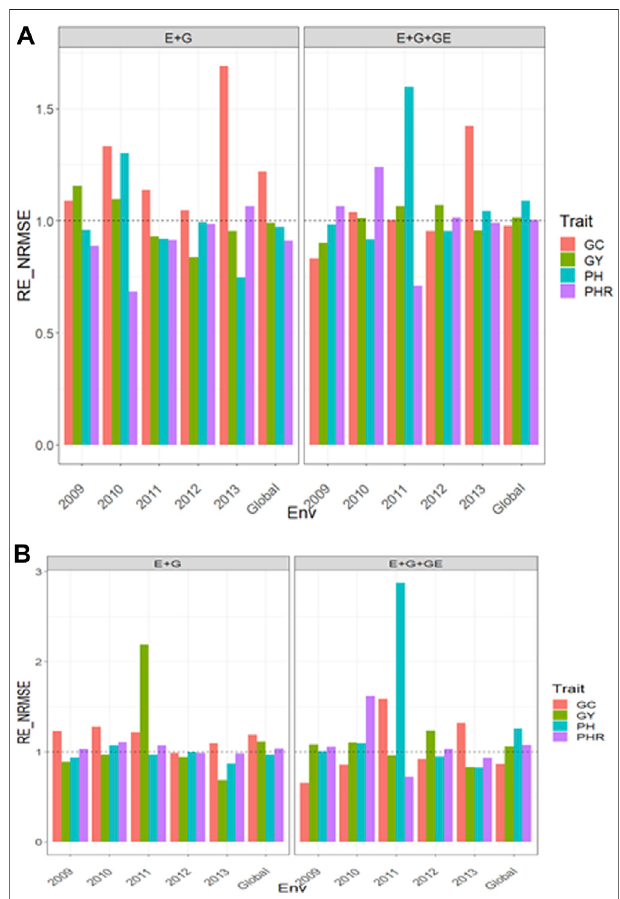
FIGURE 9 | Relative ef fi ciency in terms of normalized root mean square error (RE_NRMSE) computed by dividing the NRMSE under the best linear unbiased predictor model (GBLUP) between the NRMSE of the partial least squaresregressionmethod.Predictionperformanceisreportedforeach environment and across environments (Global) in dataset 14 (Japonica), also withtwopredictors(E+GandE+G+GE).WhentheRE_NRMSE > 1,thePLS outperforms the GBLUP method in terms of prediction performance (lower NRMSE). (A) With environmental covariates (EC) and (B) without EC.